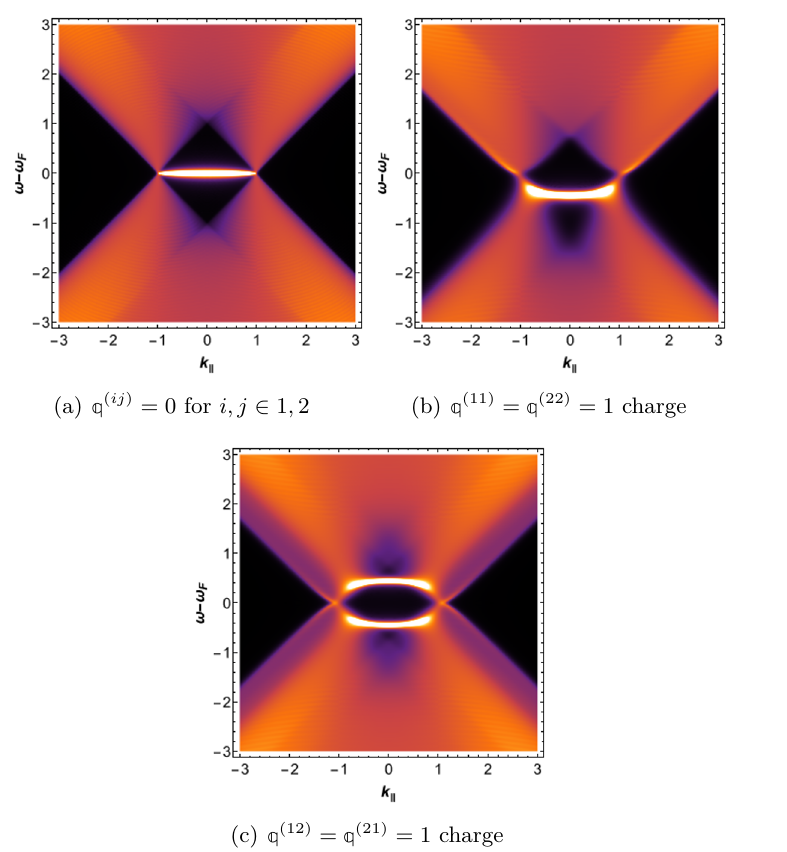
Figure 6 . Bending effect of Holographic ABC-MLG by chemical potential µ in different charge matrix with B ( − 1) xy = 1 , µ = 0 . 5